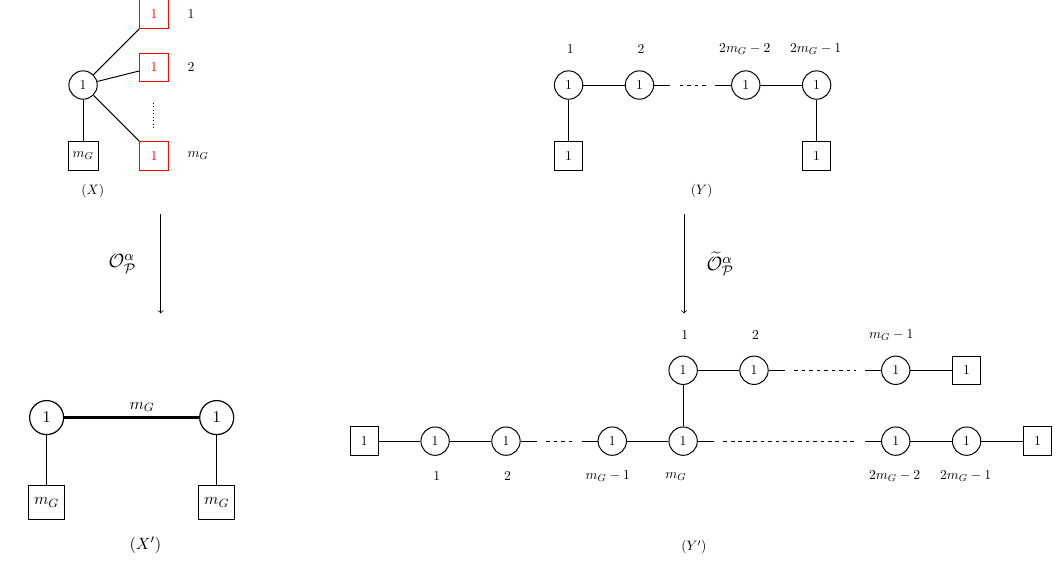
Figure 8 . Construction of the pair of mirror dual theories ( X 0 , Y 0 ) , by a single elementary Abelian S -type operation of the identification-flavoring-gauging type. The dual operation involves attaching a balanced linear chain of U(1) gauge nodes to the U(1)